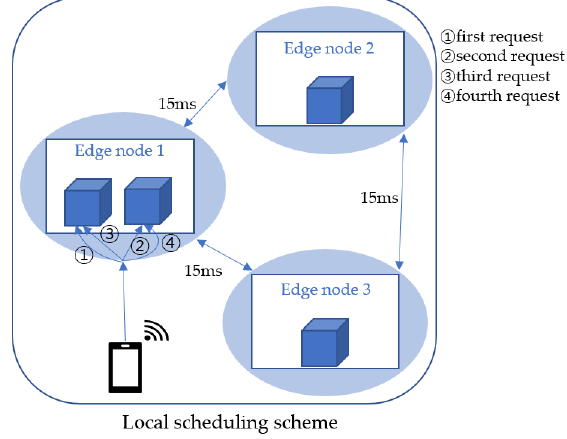
Figure 3. Local scheduling scheme in KubeEdge.